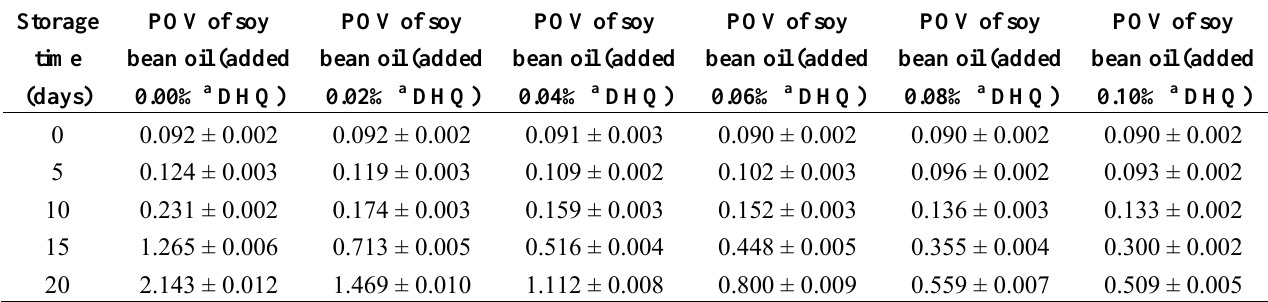
Table 3. POV of soy bean oil after addition of DHQ during storage at 60